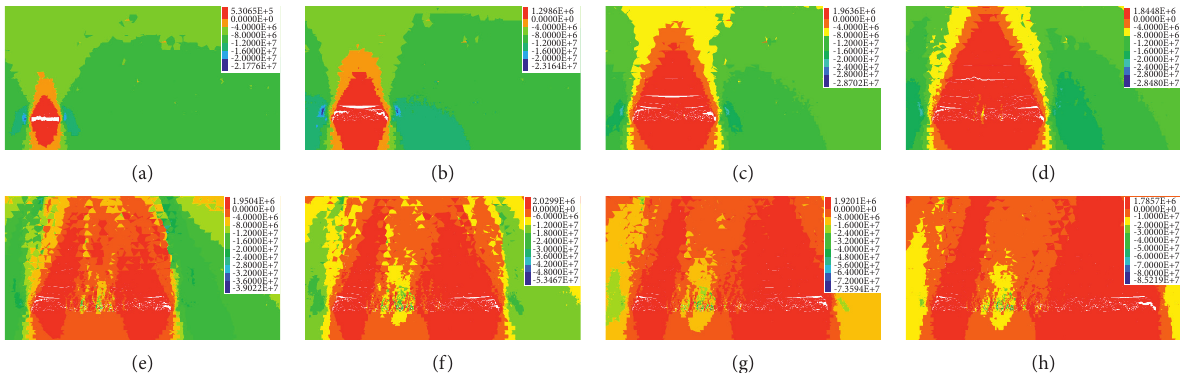
Figure 7: Vertical stress distributions around the mined-out area. (a) Stage 1 (20m). (b) Stage 2 (40 m). (c) Stage 5 (60m). (d) Stage 4 (80m). (e) Stage 5 (100m). (f) Stage 6 (120m). (g) Stage 7 (140m). (h) Stage 8